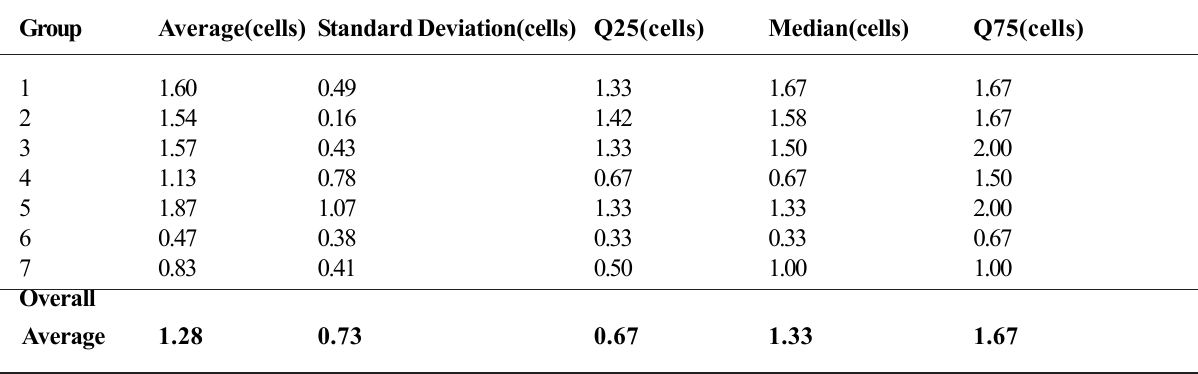
TABLE 4 — Measures of polymorphonuclear cells (cells), with Arithmetical Average, Standard Deviation, Q25, Median, Q75 of all Groups, individually and